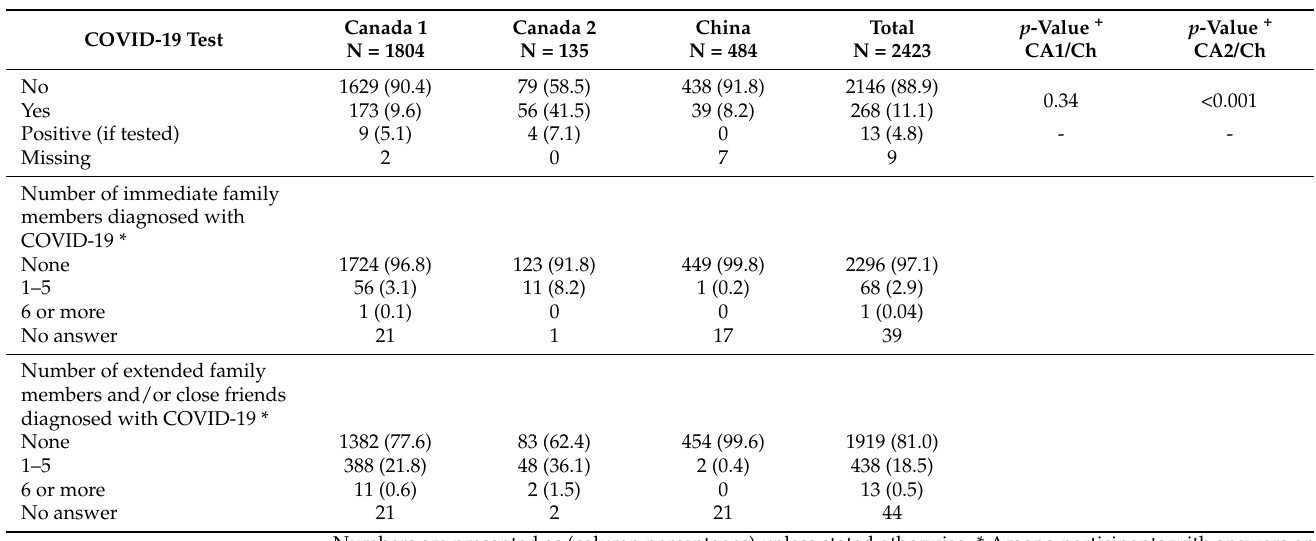
Table 3. SARS-CoV-2 testing and COVID-19